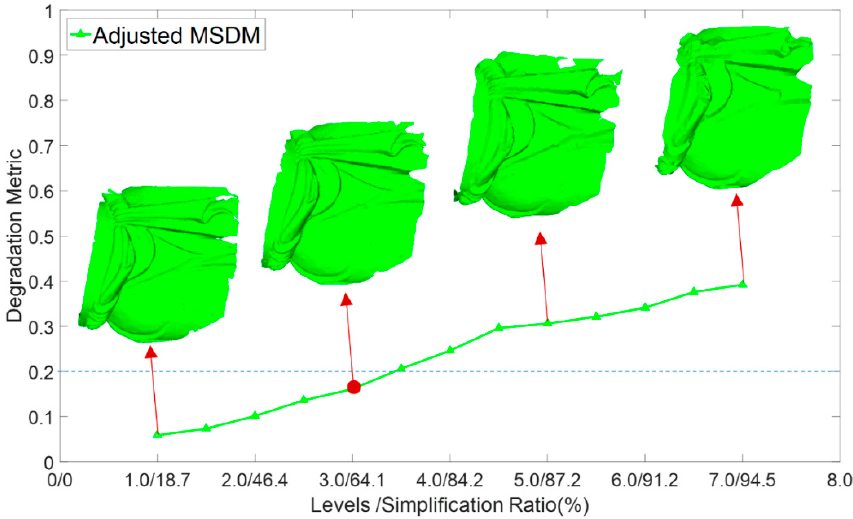
Figure 9. Optimal level selection of small point cloud.